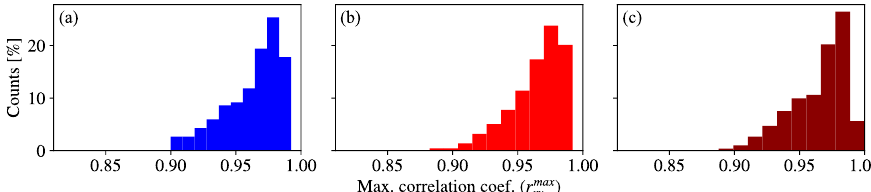
Figure 5. Distribution of maximum correlation coefficient values of image sequences taken ( a ) under a cool room temperature of 21.7 ◦ C (no turbulence), ( b ) under a warm room temperature of 32.3 ◦ C and with heaters off, and ( c ) with turbulence induced by the